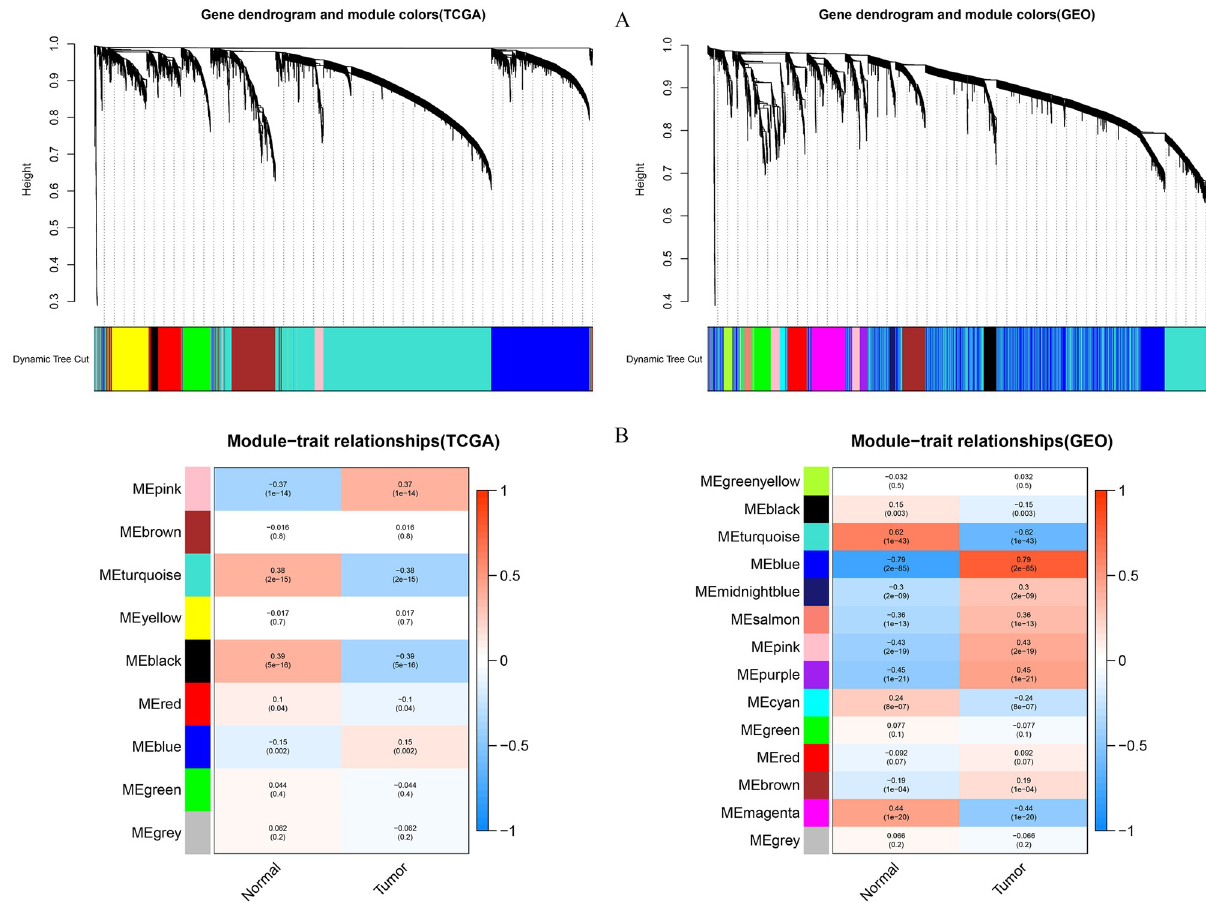
Fig 2. Identification of co-expression modules associated with clinical features in gastric cancer. The results on the left are from TCGA, and those on the right are from GSE66229 (A) Gene cluster dendrograms and module colors. The gene dendrogram is obtained by overlaying the topology with the corresponding module colors. Each color represents an independent module that contains a set of highly-related genes. (B) Heat map of the correlation between co-expression module genes and clinical features (tumor and normal), the top number in each cell is the correlation coefficient, and the bottom one is the